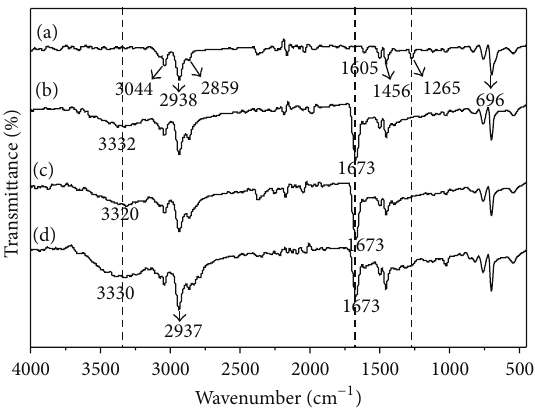
Figure 3: ATR-FTIR of MR resin (a), MR-EDA resin (b), MR-DETA resin (c), and MR-TETA resin (d).